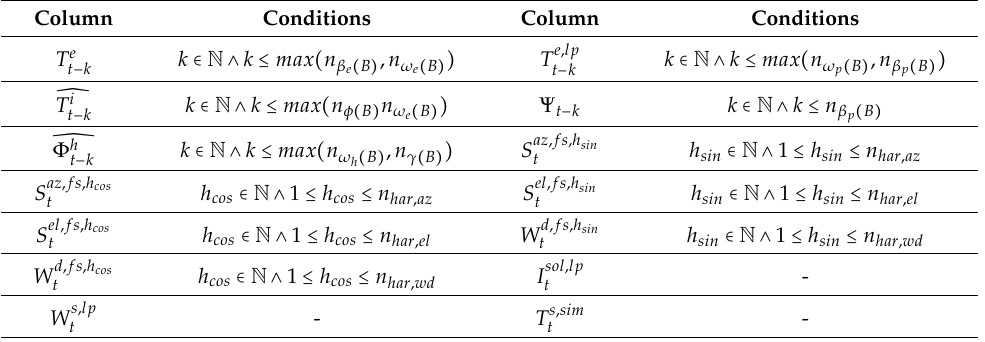
Table A1. Columns of A matrix.